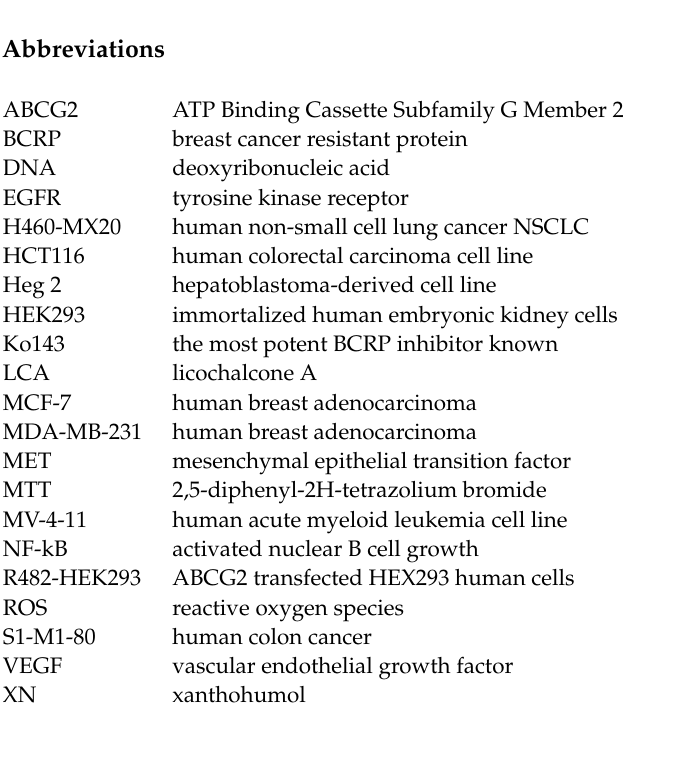
Figure S2: Claisen-Schmidt reaction. Table S1: Chemical structures of flavonoids. Table S2: The name and chemical formula of compounds. Table S3: Half-maximal inhibitory concentration (IC50) of the most effective chalcones